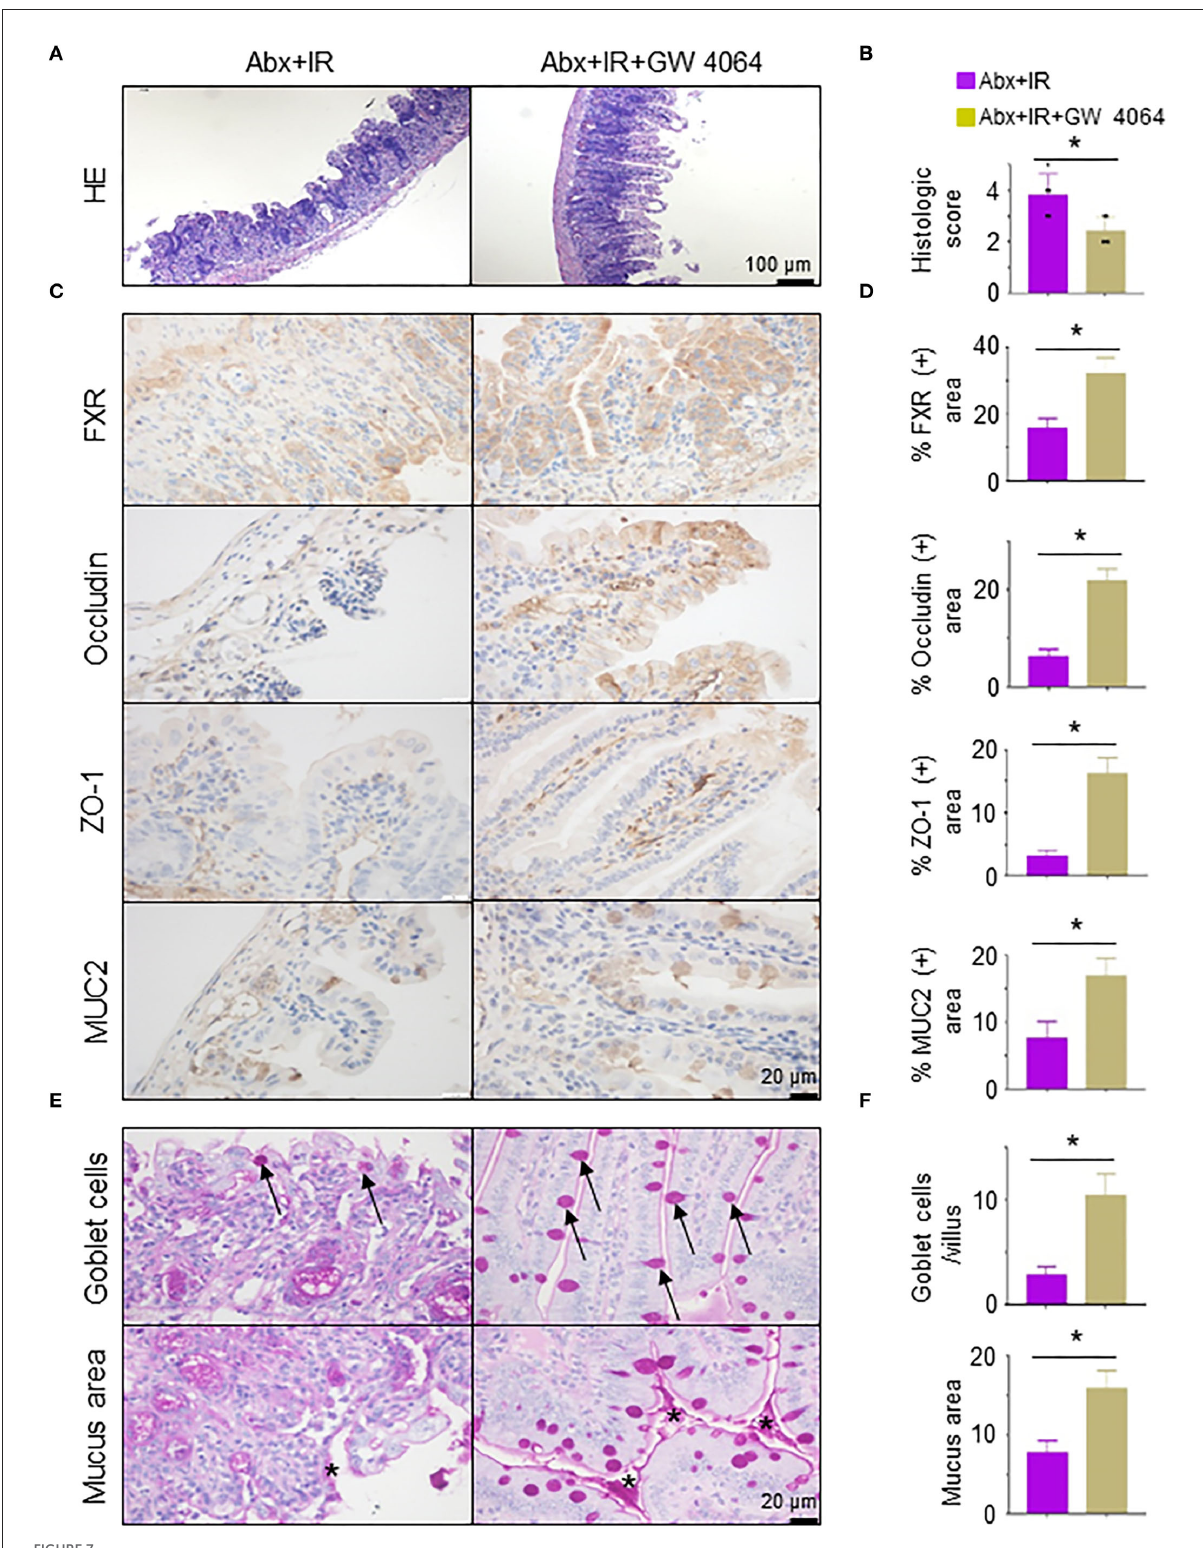
FIGURE7 Activation of FXR reduces radiation-induced intestinal injury in microbiota-eliminated mice. Microbiota-eliminated mice (Abx) were injected intraperitoneally with an FXR activator (GW 4064, 30 mg/kg/day, MedChemExpress, China) 3 days before IR. Irradiation of the mice was performed as described in Figure 1. The mice were subjected to the following analyses. (A) H&E staining of ilea in IR mice treated with FXR